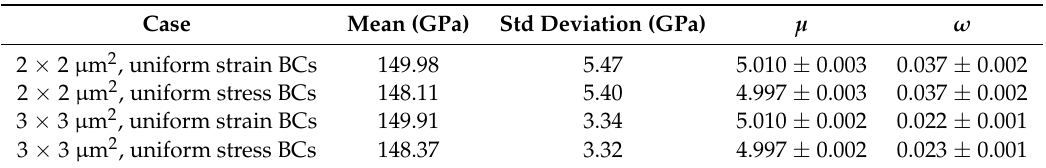
Table 1. Young’s modulus E : apparent values of the mean and standard deviation obtained with the MC analysis and parameters for the lognormal CDFs in Equation (6).